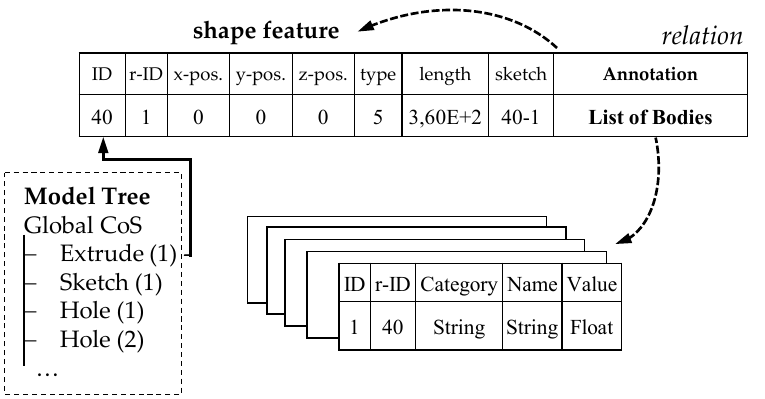
Figure 6. Illustration of the extraction of structural data (e.g., shape feature) based on [14] and expansion for the extraction of annotated semantic data by the use of the annotation